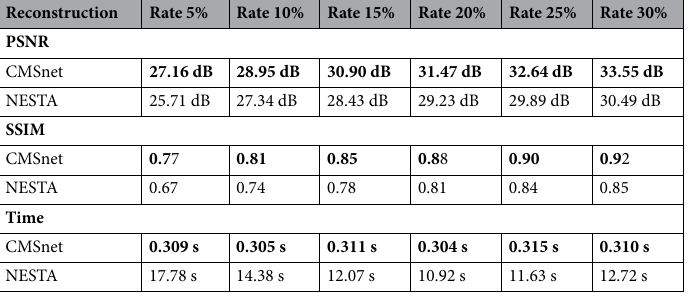
Table 1. Average PSNR, SSIM and reconstruction time at various compression rates. Significant values are in